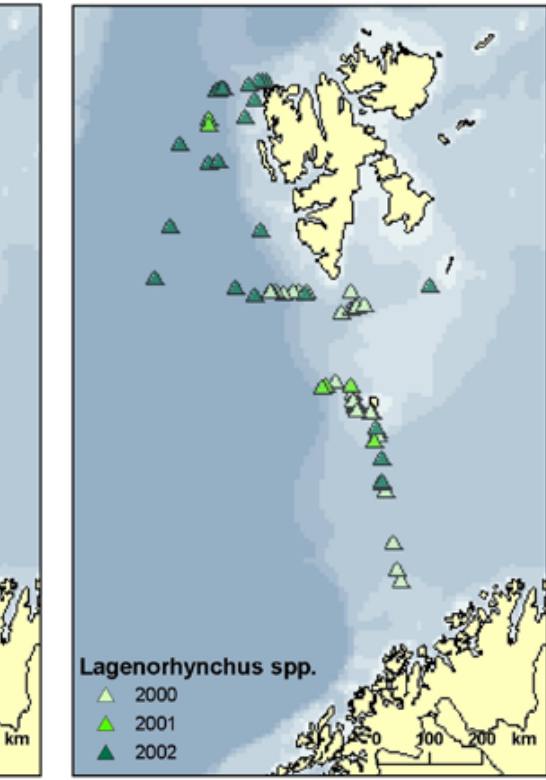
Fig. 10. Distribution of Lagenorhynchus dolphins in 2000, 2001 and